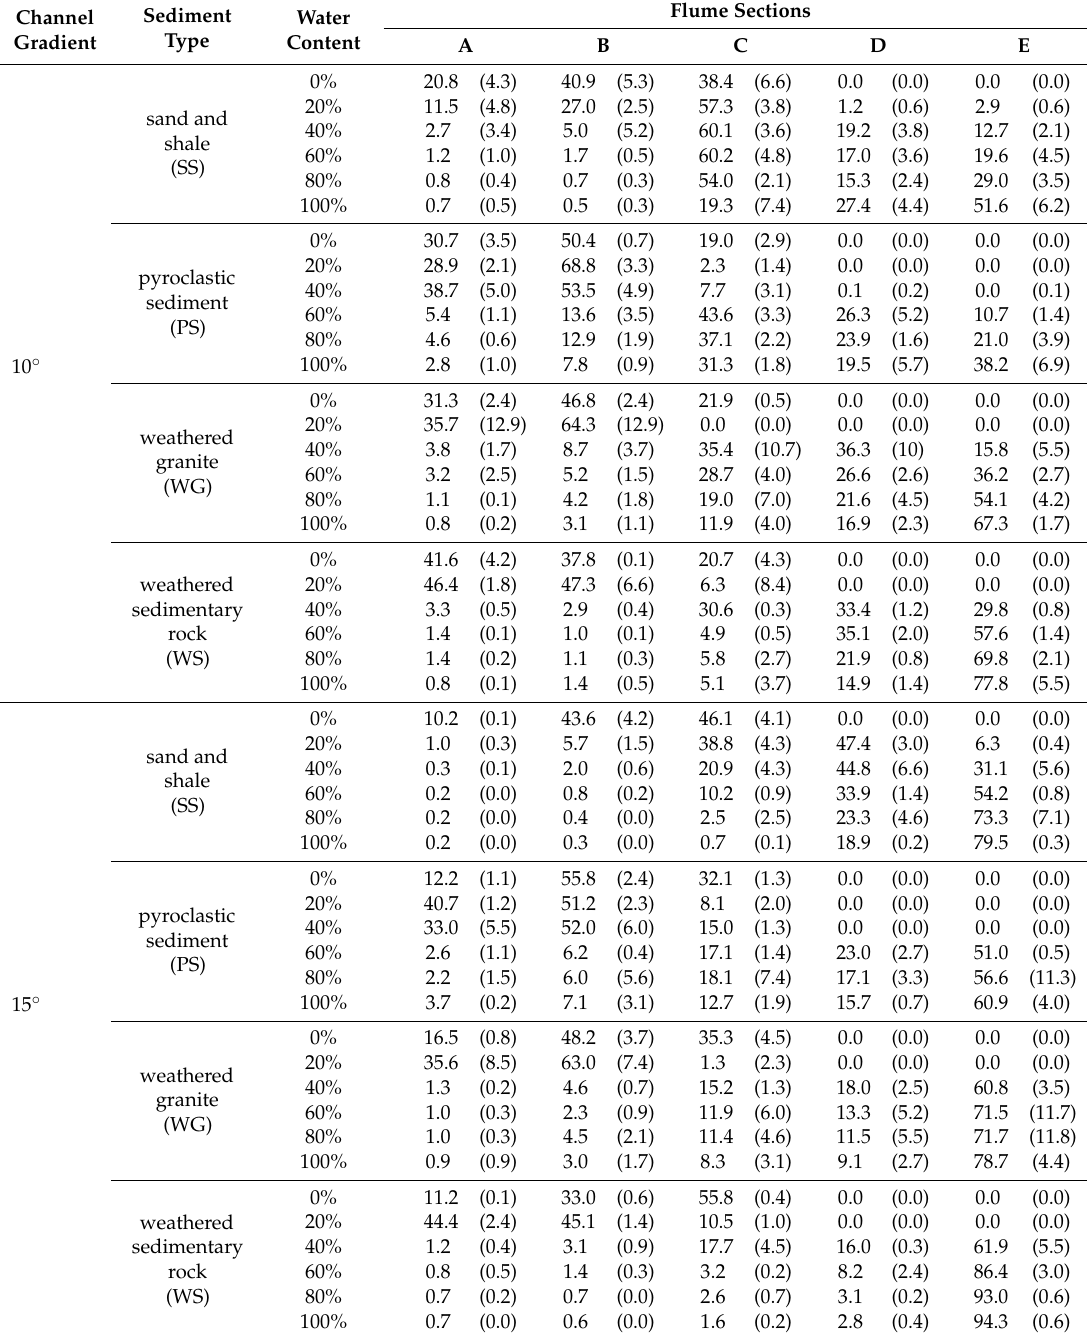
Table A2. Summary of sediment deposition for 30 ◦ inflow angle (in %). Values in parentheses indicate standard